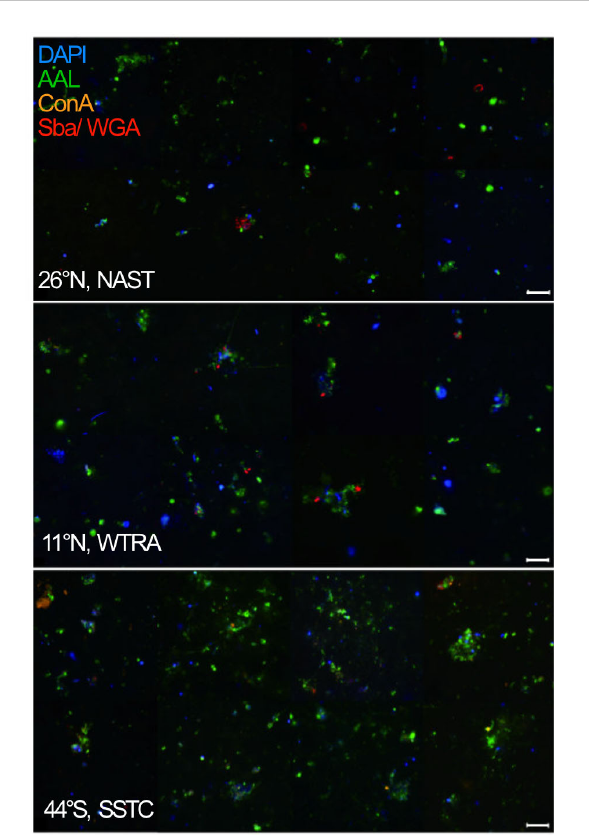
FIGURE 2 Epi fl uorescence microscope image of marine particles obtained from the S-PA fraction in the North Atlantic Subtropical (NAST), Western Tropical Atlantic (WTRA), and South Subtropical Convergence (SSTC) province of the Atlantic Ocean at 40 × magni fi cation with the super-resolution microscope. Each sample was simultaneously stained by DAPI (blue), speci fi c to DNA, and the lectins AAL (green), speci fi c to fucose, ConA (orange), speci fi c to a- mannopyranosyl and a-glucopyranosyl residues, as well as SBA and WGA (red), speci fi c to Galactose/N-acetylgalactosamine. Scale bars: 20 m